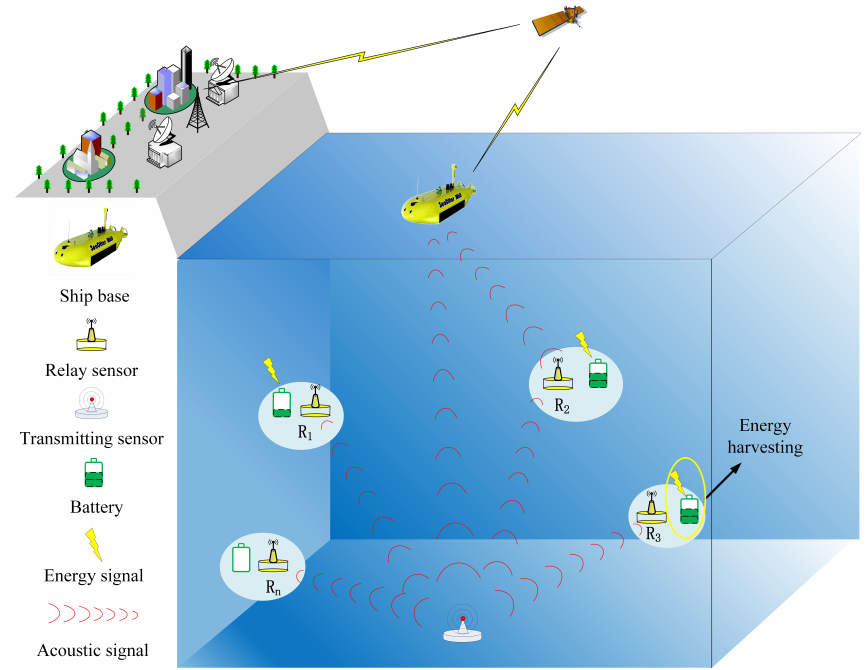
Figure 1. Illustration of underwater acoustic sensor networks (UASNs) considering energy